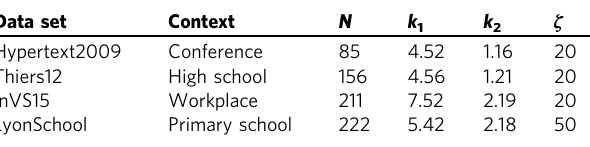
N is the number of nodes, k 1 and k 2 are the average degrees of two-body and three-body connections, respectively, ζ is a threshold to fi lter out certain connections with low interaction frequency.